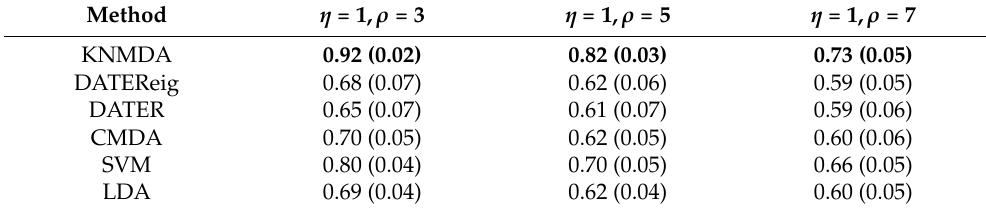
Table 2. CP data with r 1 = 3, r 2 = 3, size 5 × 5 × 5. Different columns report AUC (and standard deviation) for different levels of noise. The bold values represent the best performance for each